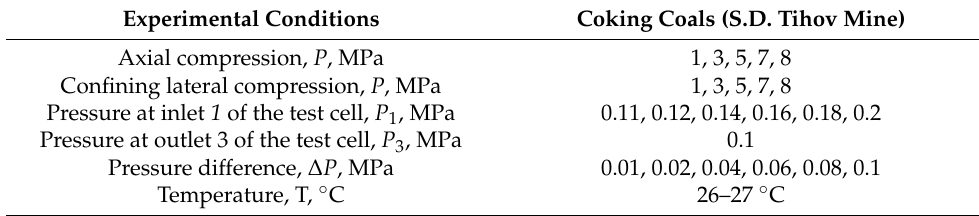
Table 2. Experimental conditions to determine coal permeability. Experimental